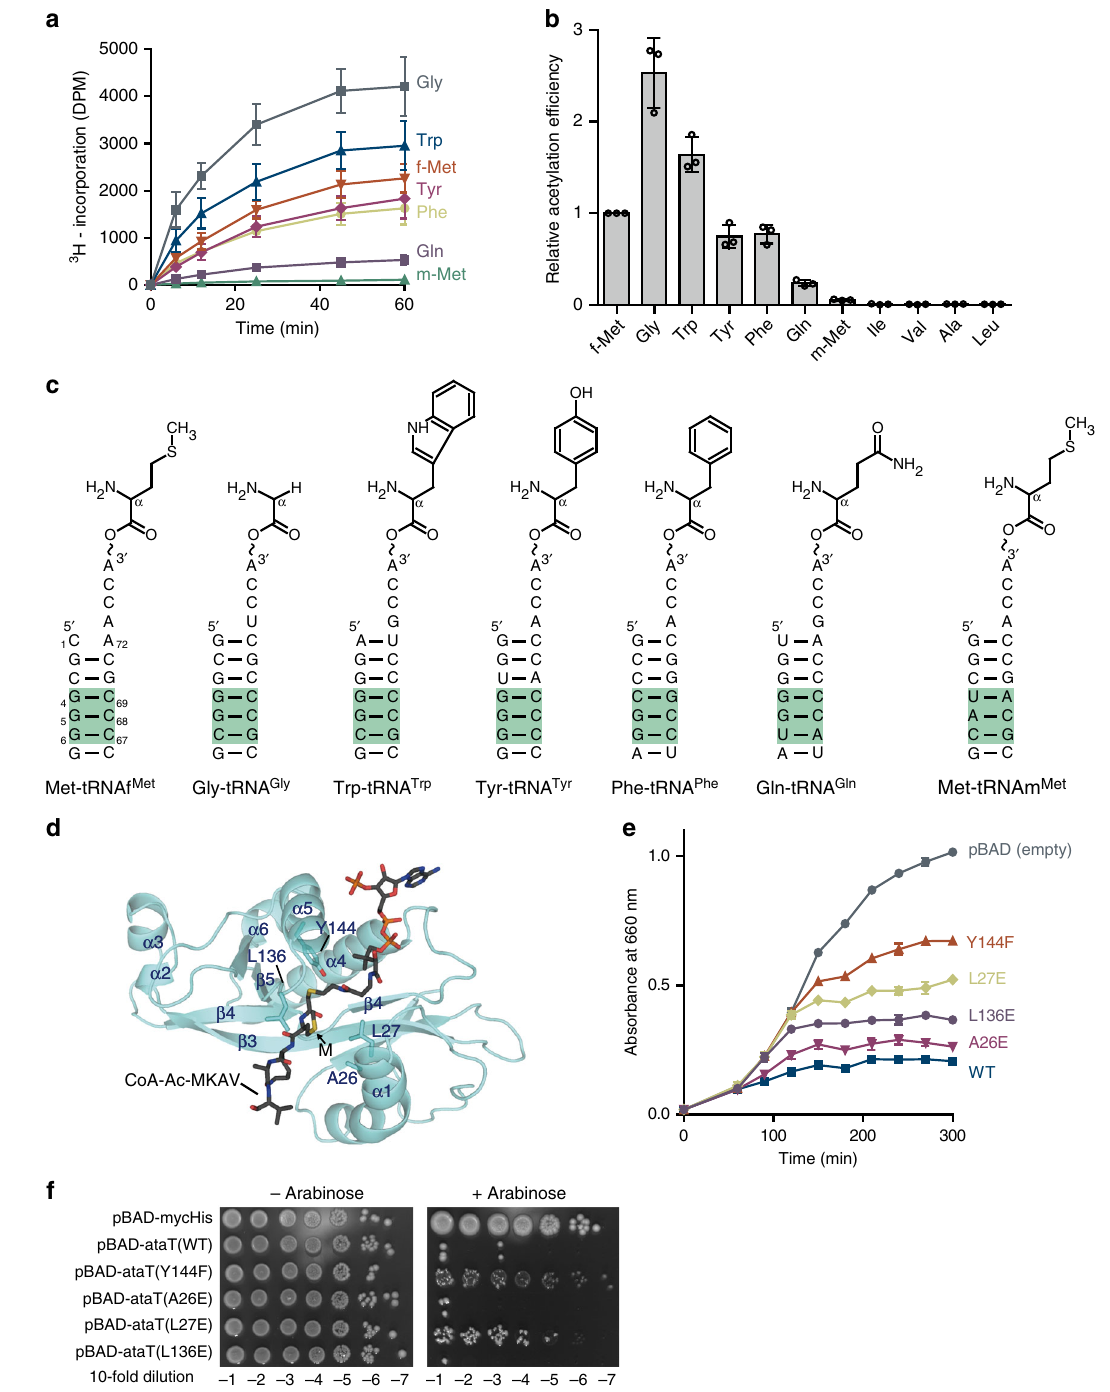
Fig. 5 Acetylation of aminoacyl-tRNAs by AtaT in vitro. a Time courses of the acetylations of Gly-tRNA Gly (Gly), Trp-tRNA Trp (Trp), Tyr-tRNA Tyr (Tyr), Phe-tRNA Phe (Phe), Met-tRNAf Met (f-Met), Met-tRNAm Met (m-Met), Leu-tRNA Leu (Leu), Ala-tRNA Ala (Ala), Ile-tRNA Ile (Ile), and Val-tRNA Val (Val) by AtaT in vitro. The respective aminoacyl-tRNAs (10 μ M) were used for the acetylation by AtaT. b Quanti fi cation of the acetylation ef fi ciencies in a . The relative initial velocities of the acetylation of various aminoacyl-tRNAs were measured. Acetylation of the Met-tRNAf Met transcript was taken as 1.0. The bars in the graph are SD of three independent ( n = 3) experiments, and the data are presented as mean values ± SD. c Nucleotide sequences of acceptor helices and chemical structures of aminoacyl-moieties of aminoacyl-tRNAs acetylated by AtaT. d Model of CoA-Ac-MKAV in the catalytic pocket of the AtaT structure. CoA-Ac-MKAV is shown in a stick model. e Growth curves of E. coli MG1655 transformed with pBAD-ataT and its variants with mutations in the putative aminoacyl moiety binding site. f Overnight cultures of E. coli MG1655 transformed with pBAD-ataT and its variants in e were serially diluted, and the dilutions were spotted on LB agar plates containing 50 μ g mL − 1 ampicillin supplemented with 0.2% (w/v) arabinose or without arabinose. The plates were incubated at 37 °C